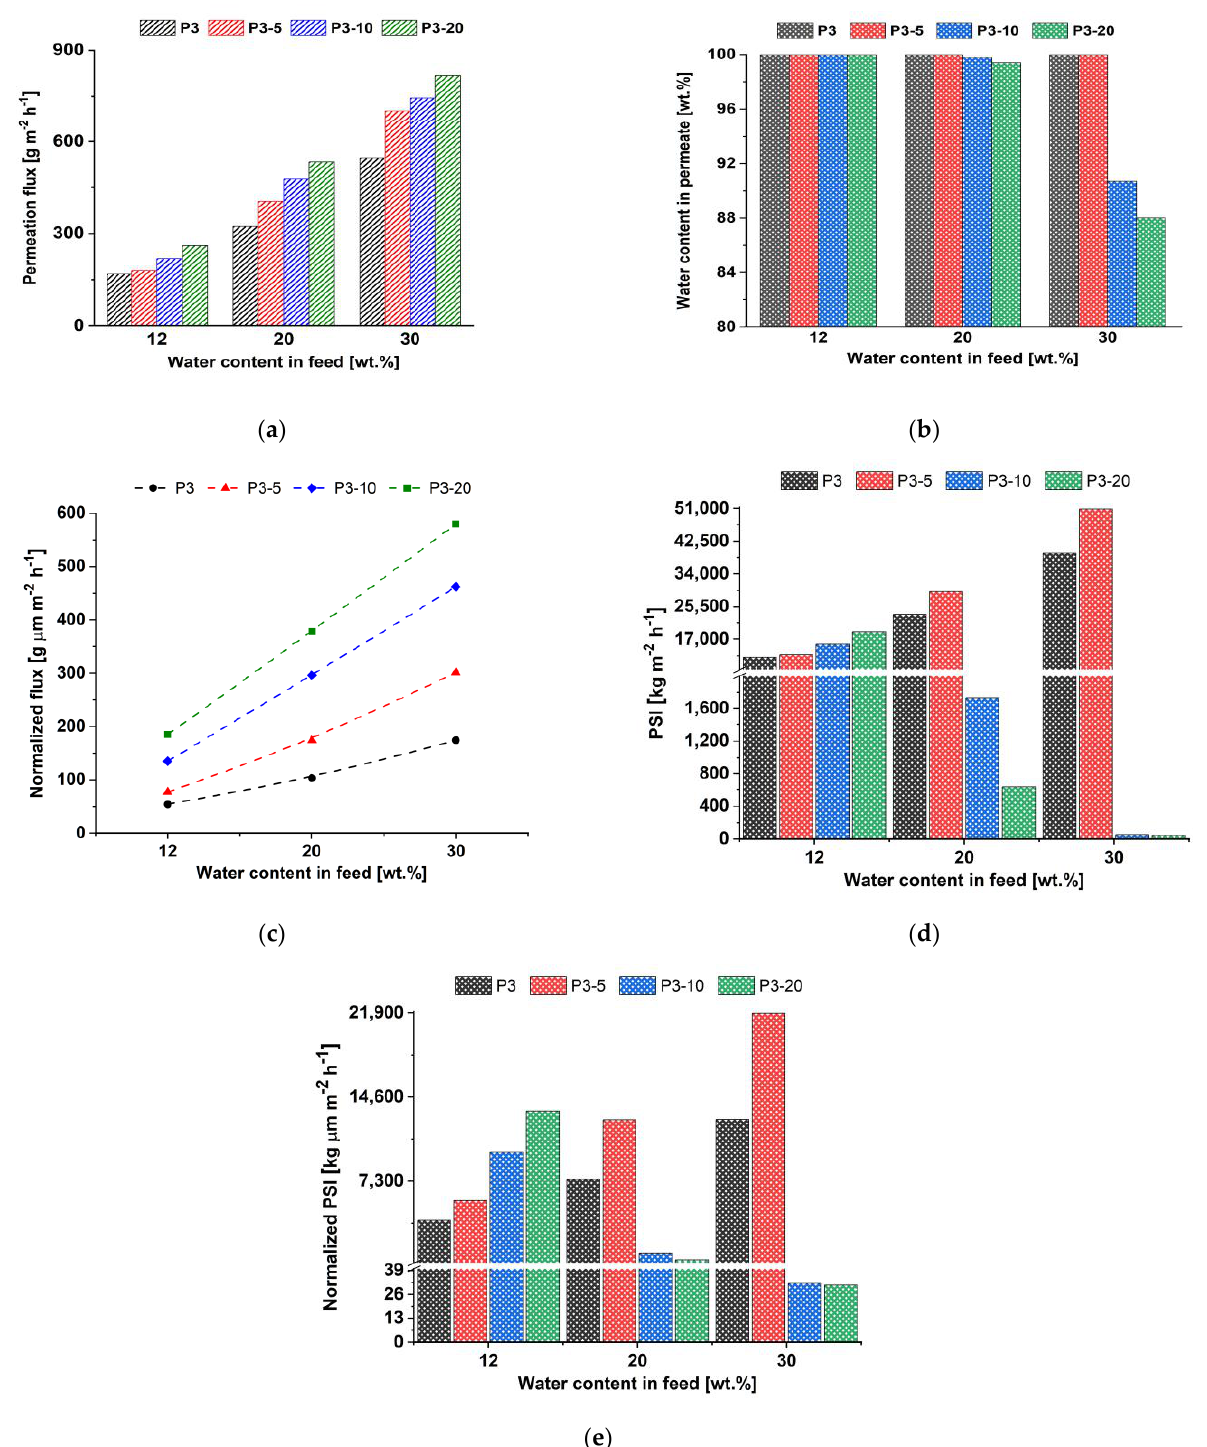
Figure 12. Dependence of permeation flux ( a ), water content in permeate ( b ), normalized permeation flux ( c ), PSI ( d ) and normalized PSI ( e ) on the water content in feed solution in pervaporation of isopropanol/water mixture for ChS-Fe-BTC/PAN membranes prepared by physical adsorption with different content of Fe-BTC in the selective layer.